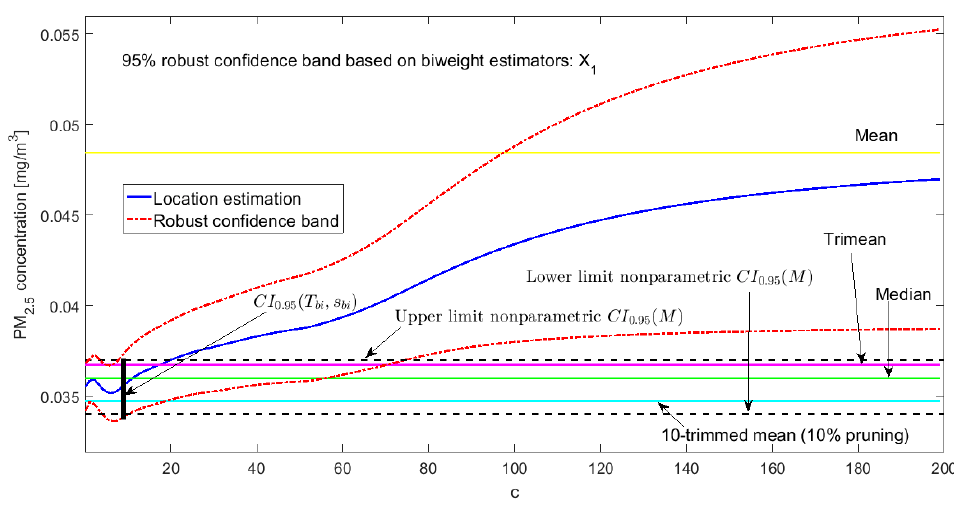
Figure 12. 95% robust confidence band based on the Andrew’s wave: 𝑋 (cid:2869) .